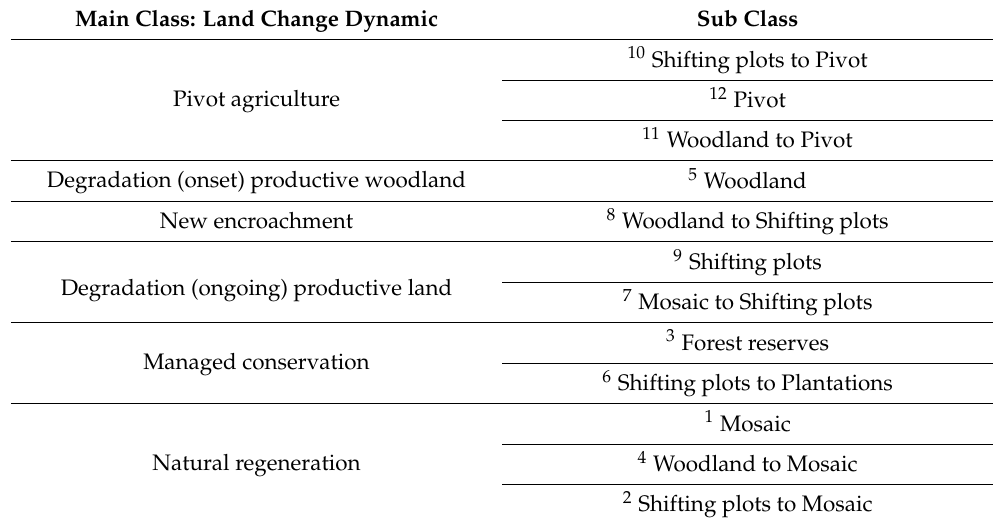
Main Class: Land Change